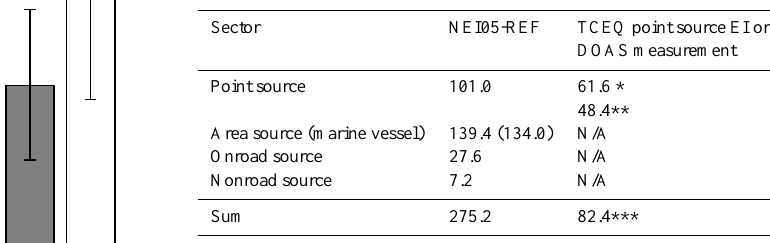
Table 6. NO x emissions (metric tons as NO 2 /day) in NEI05-REF, TCEQ point source emission inventory (EI) in 2006, and DOAS measurements in 2006 (Rivera et al., 2010) for the Houston Ship Channel. The latitude and longitude limits of the Houston